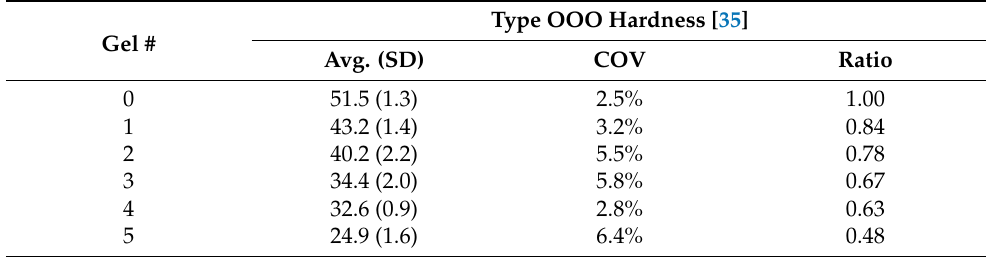
Table 2. Summary of hardness test results.